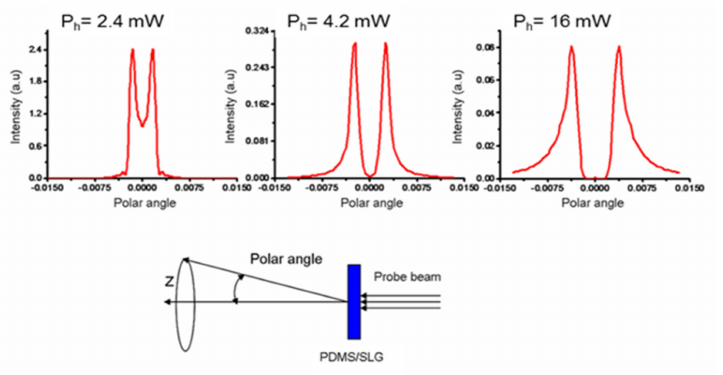
Figure 5. Upper part: Theoretical far field at three different heating powers P h at the wavelength of 633 nm. Lower part: definition of the polar